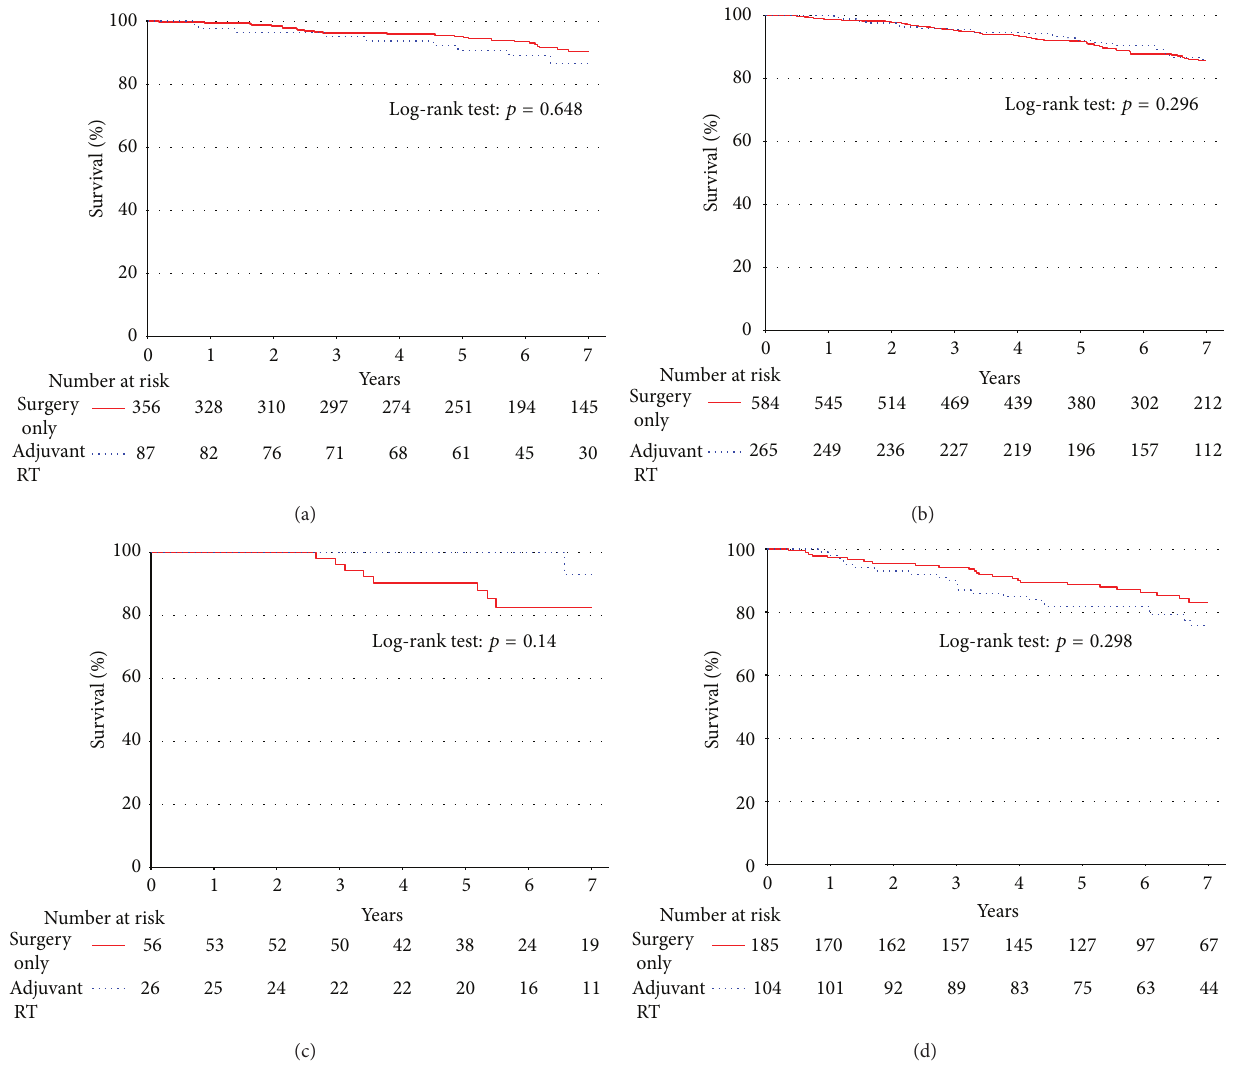
Figure 3: There is no difference in unadjusted survival for patients with well-differentiated tumors when stratified by adjuvant RT versus surgery on the basis of size < 5 cm (a) and > 5 cm (b) for patients with negative margin status. There was also no difference when stratified on the basis of size in patients with positive margin status ((c) and (d),